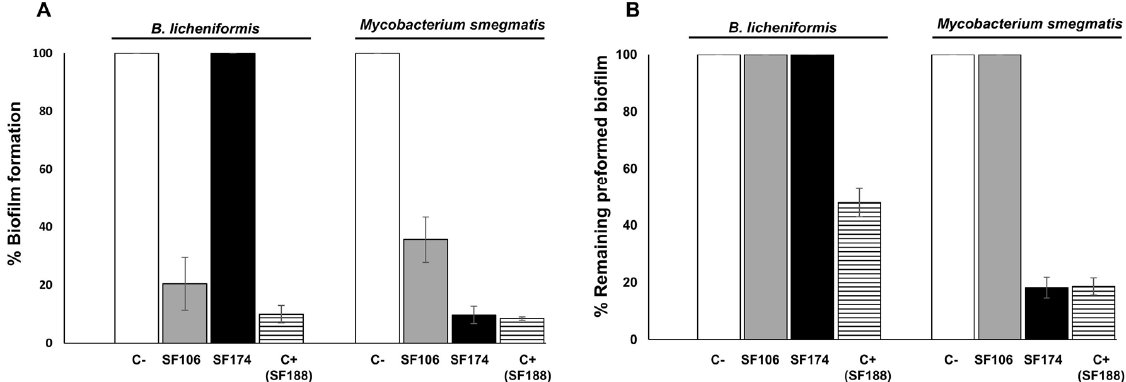
Figure 7. Effects of cell-free supernatants of SF106 and SF174 in preventing biofilm formation ( A ) and in disassembling pre-formed biofilms ( B ) of the indicated target bacteria. Biofilm formation and dis-assembly were assayed without any cell-free supernatant (C-) and with the cell-free supernatant of strain SF188 (C+), a B. pumilus strain [22], here used as positive control.